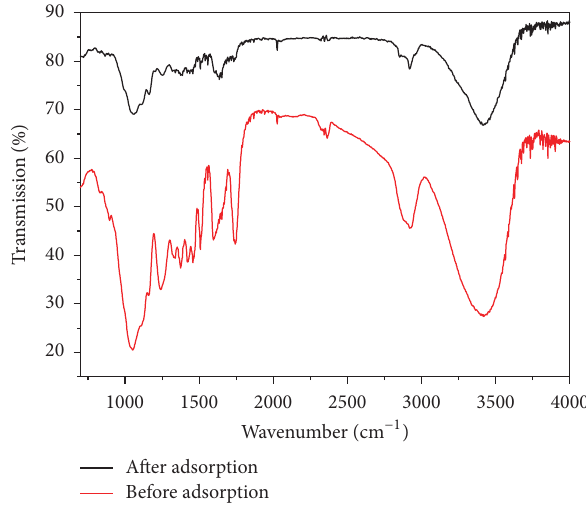
Figure 1: FTIR spectrum of walnut shell particles, before and after